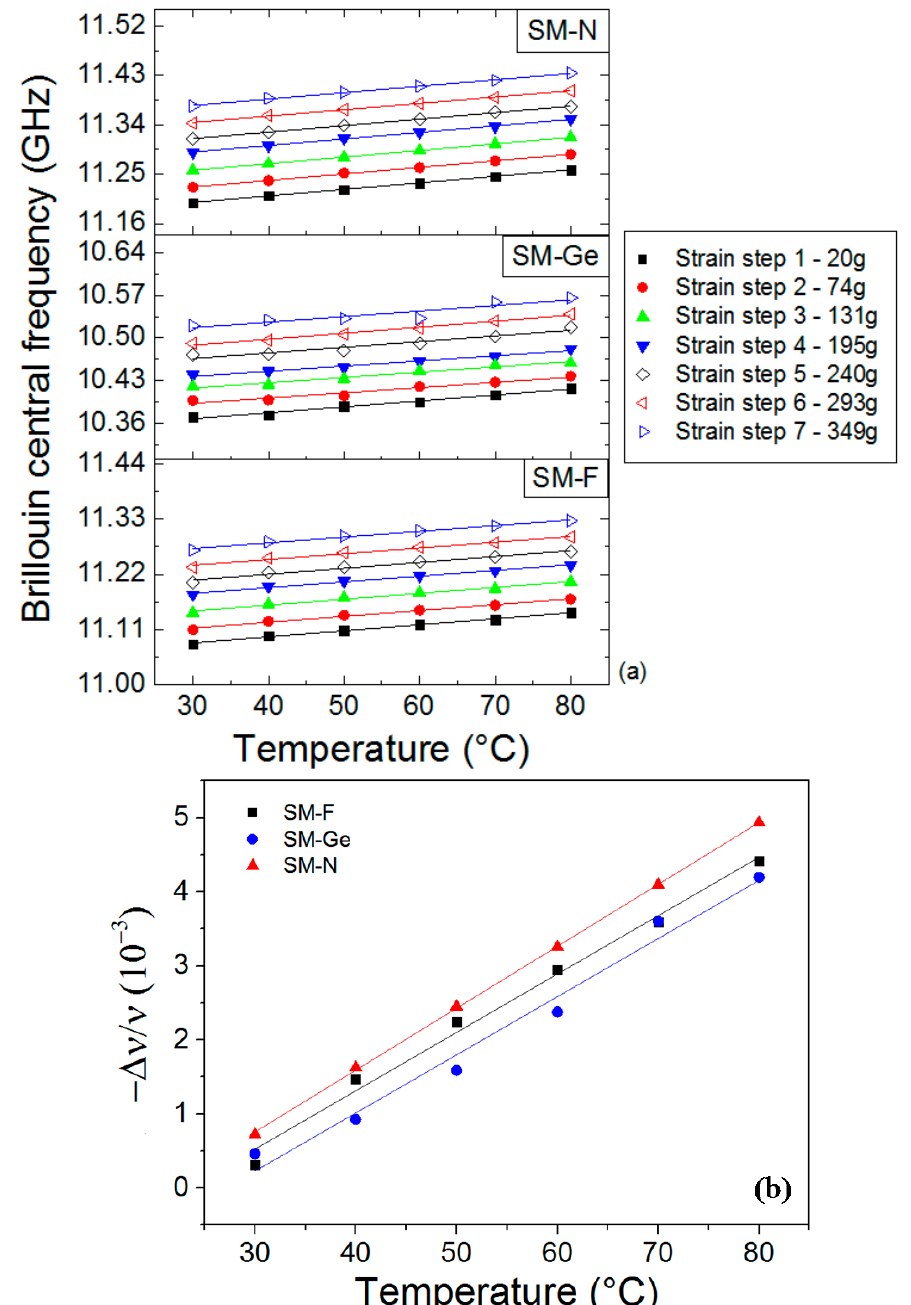
Figure 11. Brillouin central frequency ( a ) and Rayleigh relative spectral shift ( b ) evolutions as a function of temperature after irradiation at a dose of 56 kGy for the F-doped, Ge-doped and N-doped samples.